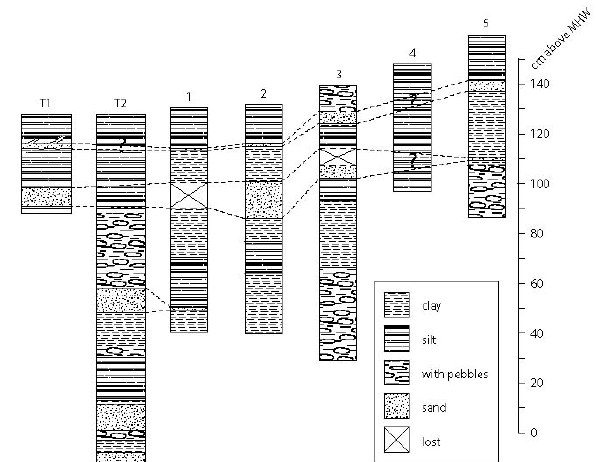
Fig. 4. One of trenches opened in Kirra.